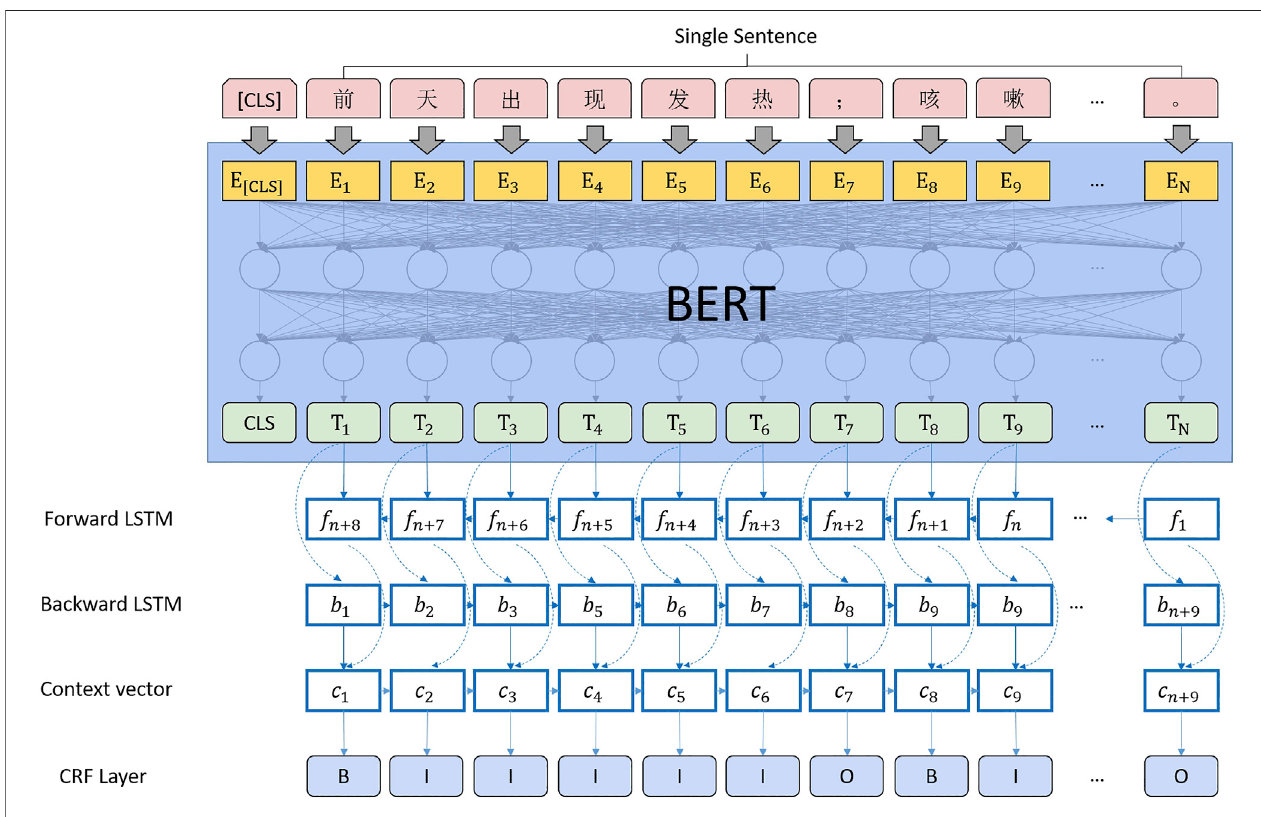
FIGURE 7 | Entity extraction computing